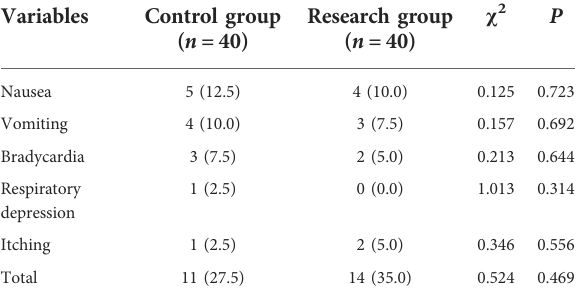
TABLE 2 Comparison of adverse reactions at 48 h after surgery between two groups ( n , %).